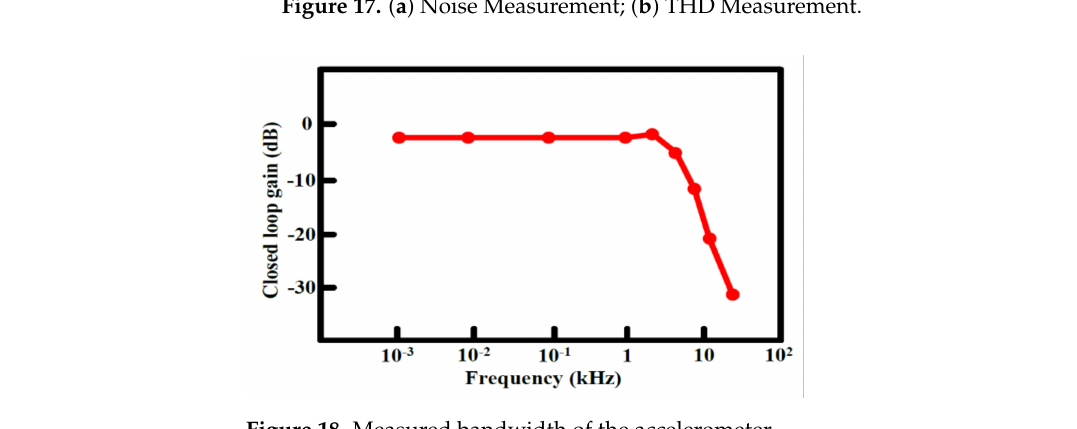
Figure 18. Measured bandwidth of the accelerometer. Table 1. Performance summary and